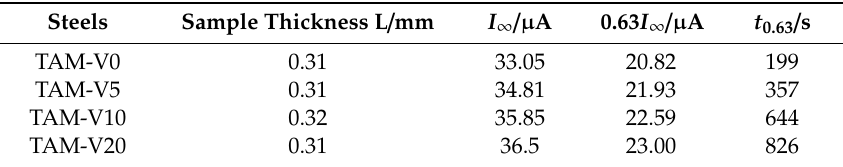
Table 3. Hydrogen permeation results.